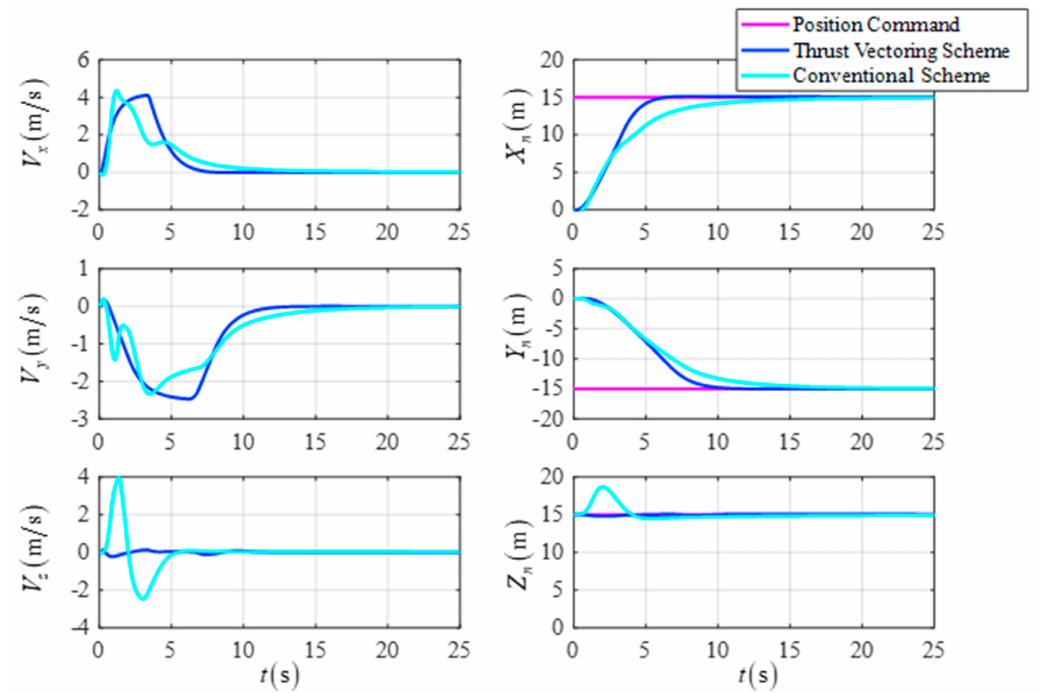
Figure 12. The position and the velocity in the fixed height flight.